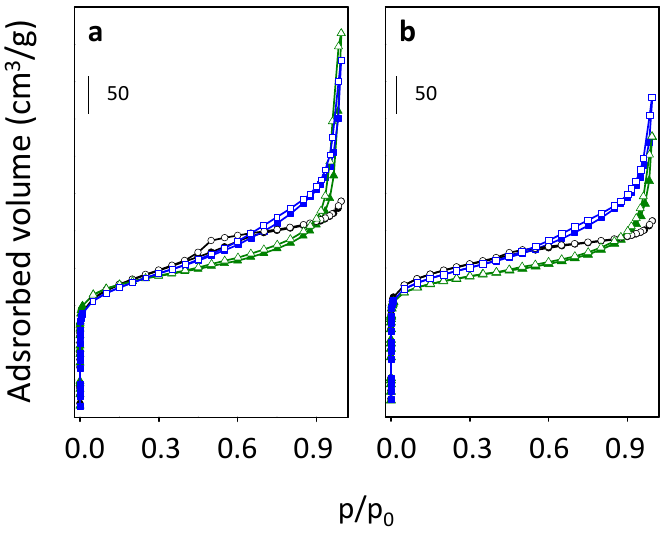
Figure 6. Low ‐ temperature N 2 adsorption (full symbols) and desorption (empty symbols) isotherm registered for B1 (black), B2 (blue) and B3 (green) samples calcined in ammonia ( a ) and in air ( b ).